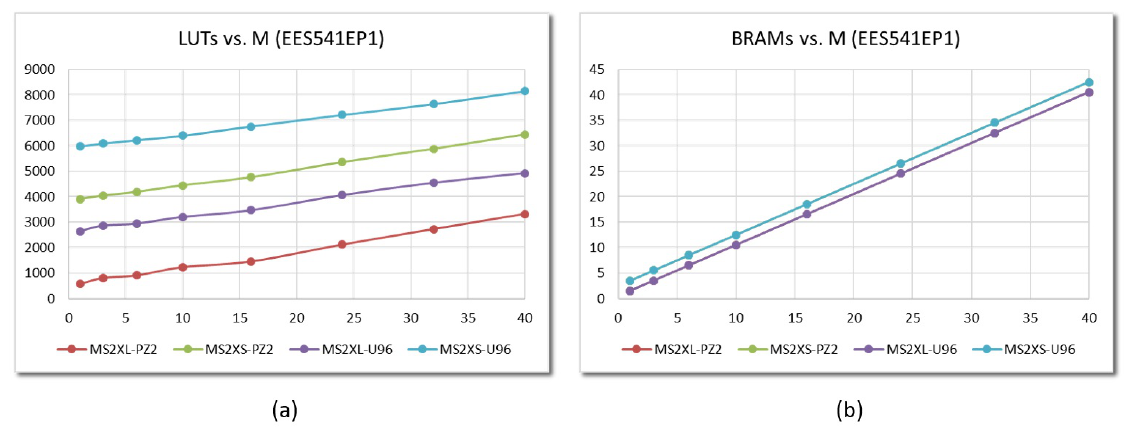
Figure 15. LUTs ( a ) and BRAMs ( b ) required to implement embedded systems that incorporate MS2XL and MS2XS multipliers on Zynq-7000 and Zynq UltraScale+ devices for the parameter set EES541EP1 and different values of M .